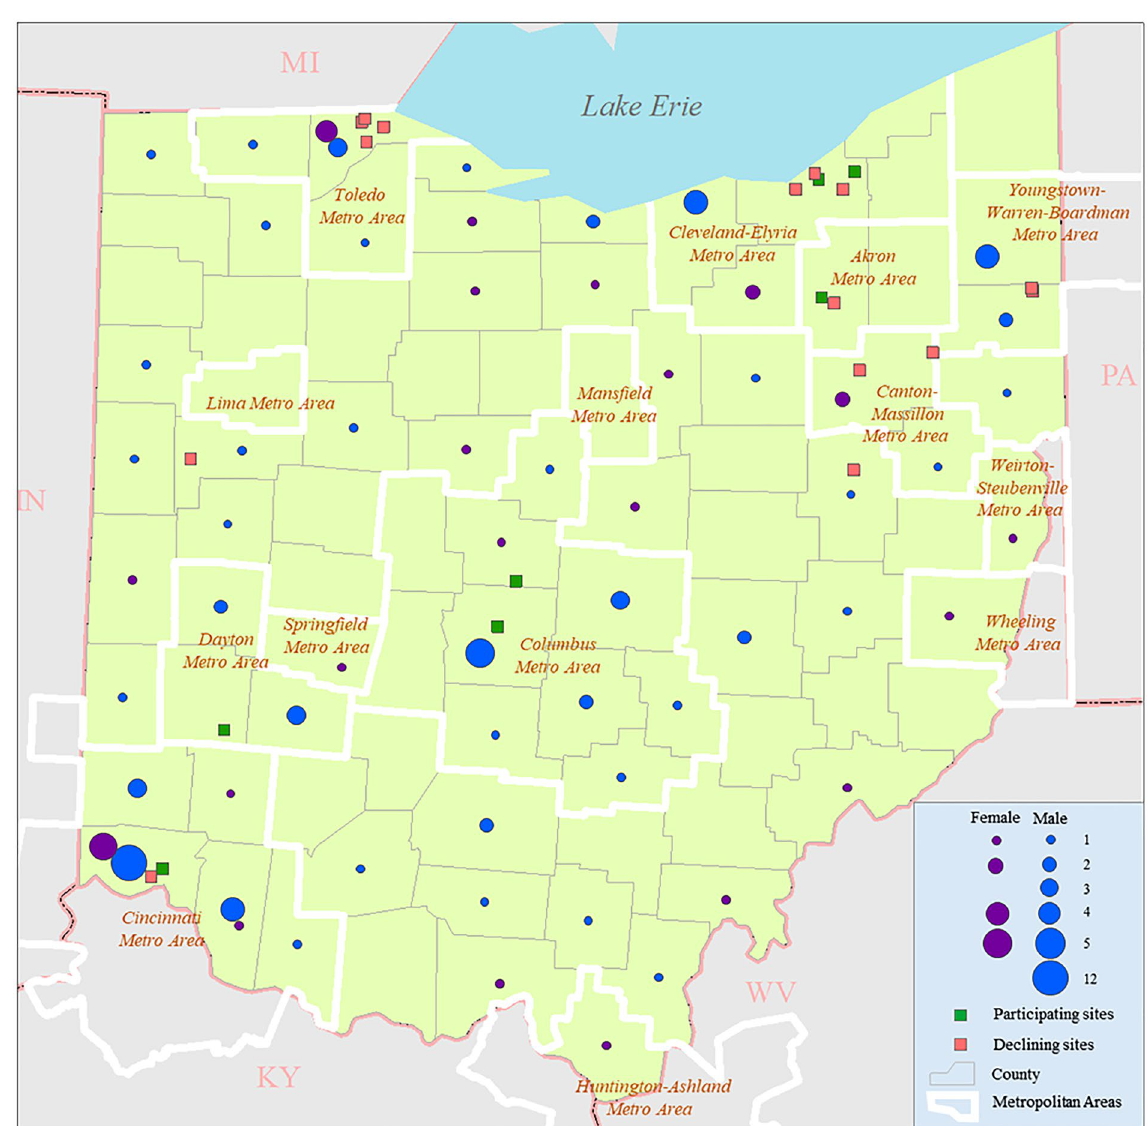
Figure 1. Estimated numbers of unrecruited ALS cases in individual Ohio